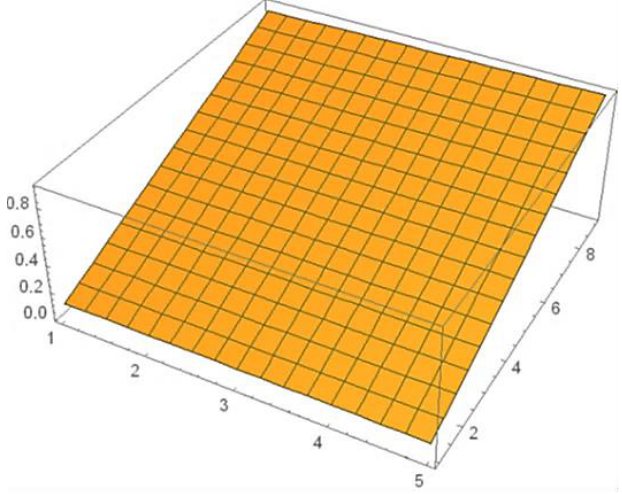
Figure 6. The exact solution (upper solution) of Equation (33) at t = 0.01, x 0.1, r = 0 and β = 0. The numerical results in double parametric form that are obtained by ∆ x = h = 0.1 and ∆ t = k = 0.01 to get p =